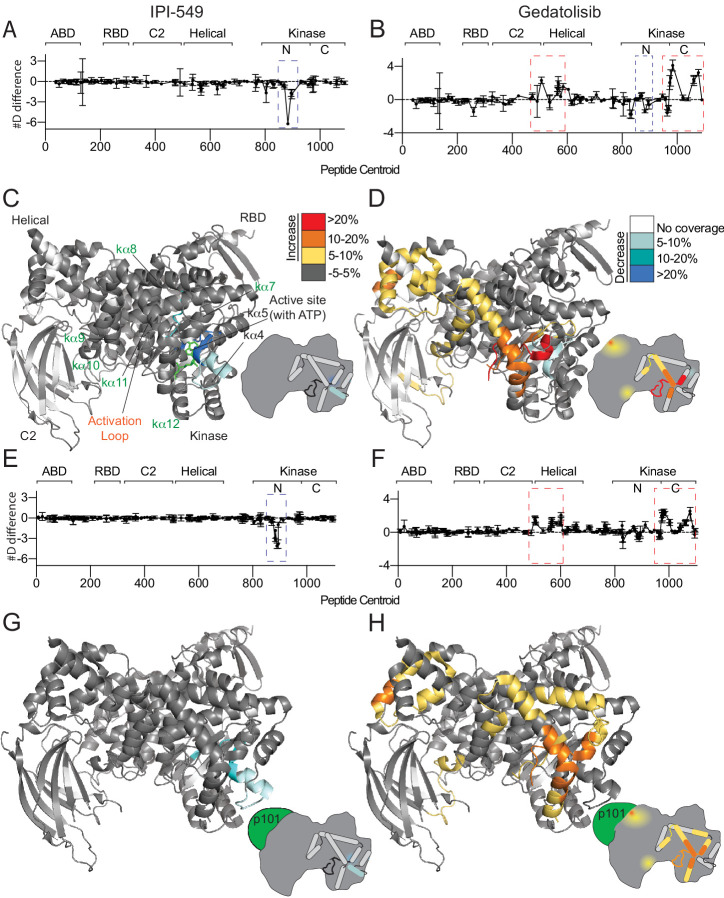
Differences in HDX for free p110γ and p110γ/p101 with selected inhibitors.(A) The number of deuteron difference for free p110γ with IPI-549 for all peptides analysed over the entire deuterium exchange time course for p110γ. (B) The number of deuteron difference for free p110γ with Gedatolisib for all peptides analysed over the entire deuterium exchange time course for p110γ. (C) Peptides showing significant deuterium exchange differences (>5%, >0.4 kDa and p<0.01 in an unpaired two-tailed t-test) between p110γ wild-type and p110γ with IPI-549. Differences are coloured on a model of p110γ (PDB: 6AUD). (D) Peptides showing significant deuterium exchange differences (>5%,>0.4 kDa and p<0.01 in an unpaired two-tailed t-test) between p110γ wild-type and p110γ with Gedatolisib. Differences are coloured on a model of p110γ (PDB: 6AUD). (E) The number of deuteron difference for the p110γ subunit in the p110γ/p101 complex with IPI-549 for all peptides analysed over the entire deuterium exchange time course. (F) The number of deuteron difference for the p110γ subunit in the p110γ/p101 complex with Gedatolisib for all peptides analysed over the entire deuterium exchange time course. (G) Peptides showing significant deuterium exchange differences (>5%, >0.4 kDa and p<0.01 in an unpaired two-tailed t-test) between p110γ/p101 wild-type and p110γ/p101 with IPI-549. Differences are coloured on a model of p110γ (PDB: 6AUD). (H) Peptides showing significant deuterium exchange differences (>5%, >0.4 kDa and p<0.01 in an unpaired two-tailed t-test) between p110γ/p101 wild-type and p110γ/p101 with Gedatolisib. Differences are coloured on a model of p110γ (PDB: 6AUD). The HDExaminer output data and the full list of all peptides and their deuterium incorporation is shown in the Figure 4—figure supplement 1—source data 1 file.
Figure 4—figure supplement 1—source data 1.Source data for HDX-MS comparing p110g/p101 with and without IPI-549/Gedatolisib.